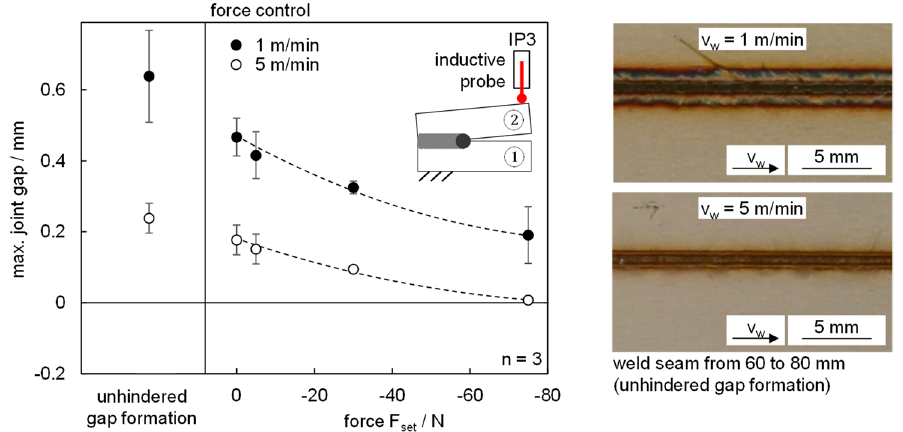
Figure 16. Comparison of maximum gap width for unhindered gap formation and force-controlled process at 1 m/min and 5 m/min welding speed and examples of weld seams.